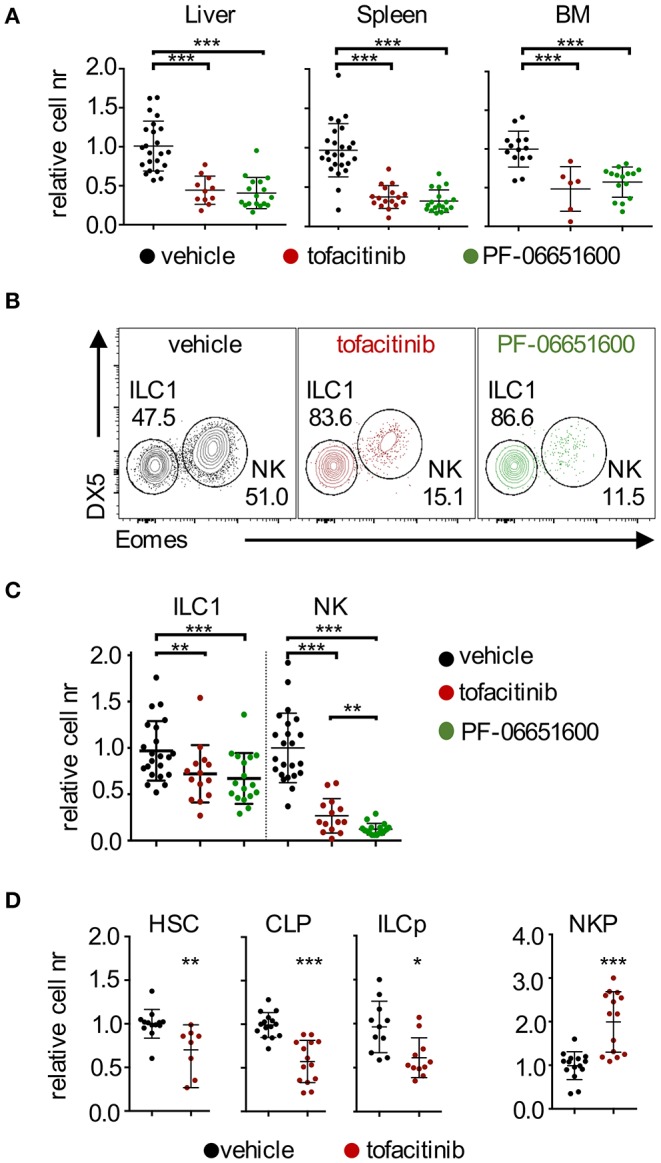
Effects of tofacitinib and PF-06651600 on ILC1, NK cells, and BM progenitors. BALB/c mice were dosed orally with tofacitinib, PF-06651600 or vehicle twice a day for 7 days. (A) Relative cell numbers for CD3ε− NKp46+ cells from liver (left panel), spleen (middle panel) and BM (right panel) are shown. ANOVA one-way test was applied. (B) Subsets of liver NKp46+ cells were distinguished by the expression of Eomes and DX5/CD49b. ILC1 were defined as DX5−Eomes− cells and NK cells as DX5+Eomes+ cells. Percentages depicted in dot plots are representative. (C) Relative cell numbers for liver ILC1 and NK cells are shown. ANOVA one-way test was applied. (A–C) Five independent experiments were combined, and values were normalized to the mean of vehicle-treated mice in the corresponding experiment. (D) Relative cell numbers of HSC, CLP, ILCp, and NKP progenitors are shown. Student's t-test statistics are comparing samples to vehicle. Three independent experiments were combined, and values were normalized to the mean of vehicle-treated mice for each corresponding experiment. *P < 0.05; **P < 0.01; ***P < 0.001.